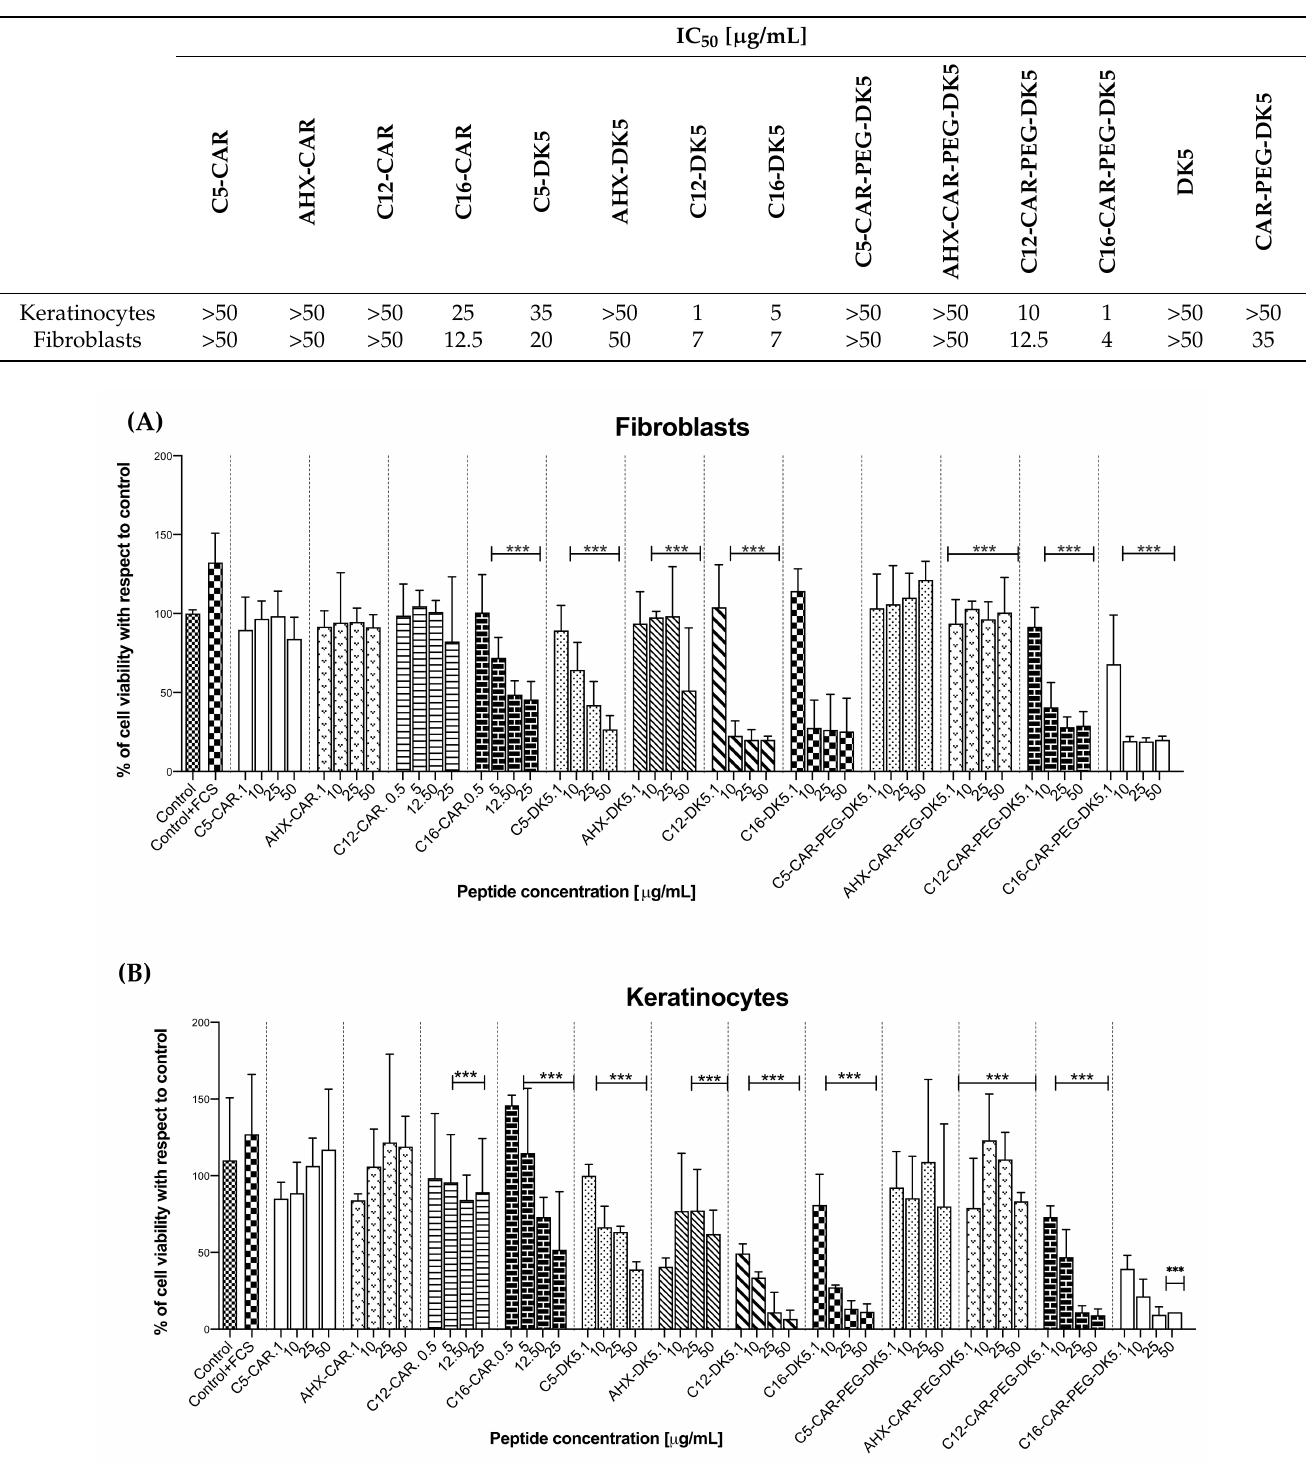
Table 4. The calculated IC 50 values established for the tested compounds toward keratinocytes (HaCaT) and primary fibroblasts’ cell lines.